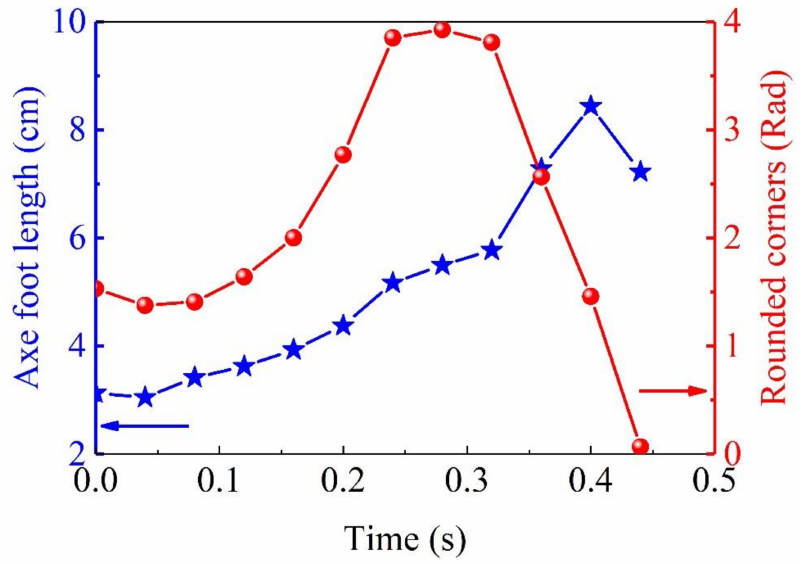
Figure 6. Variation curve of axe foot length and rounding angle of the adult Solen strictus